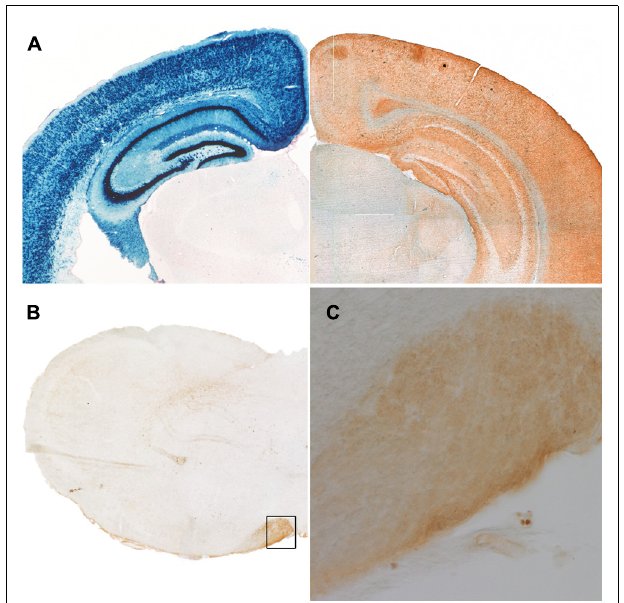
FIGUREA3 |AbundantYFP + cells in the Emx1-Cre Rosa26 YFP / + motor cortex. Sagittal section of the Emx1-Cre Rosa26 YFP / + motor cortex immunostained forYFP and the neuronal marker NeuN, which labels all cortical neurons. Note the presence of NeuN–,YFP + cells, likely corresponding to